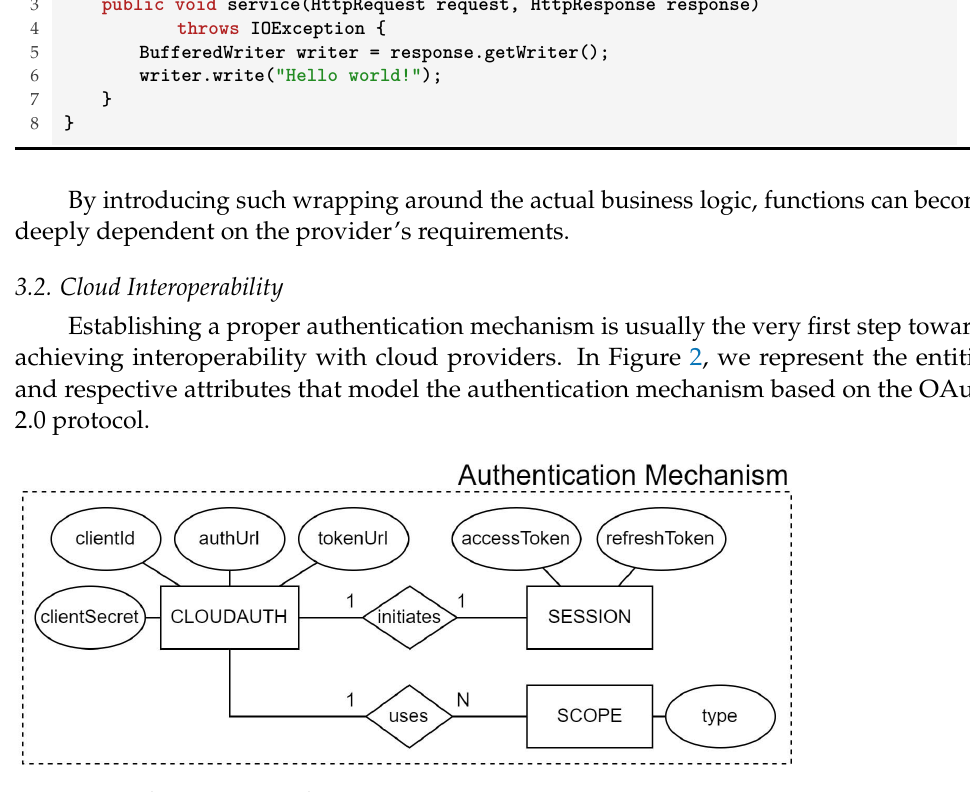
Figure 2. Authentication mechanism